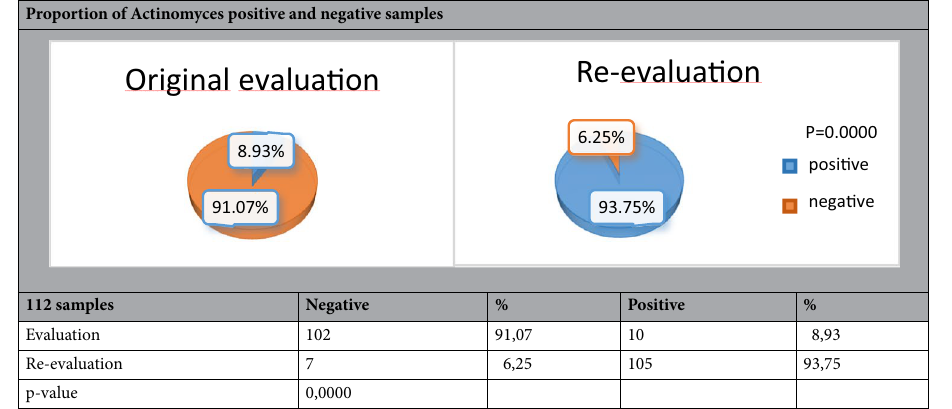
Proportion of Actinomyces positive and negative